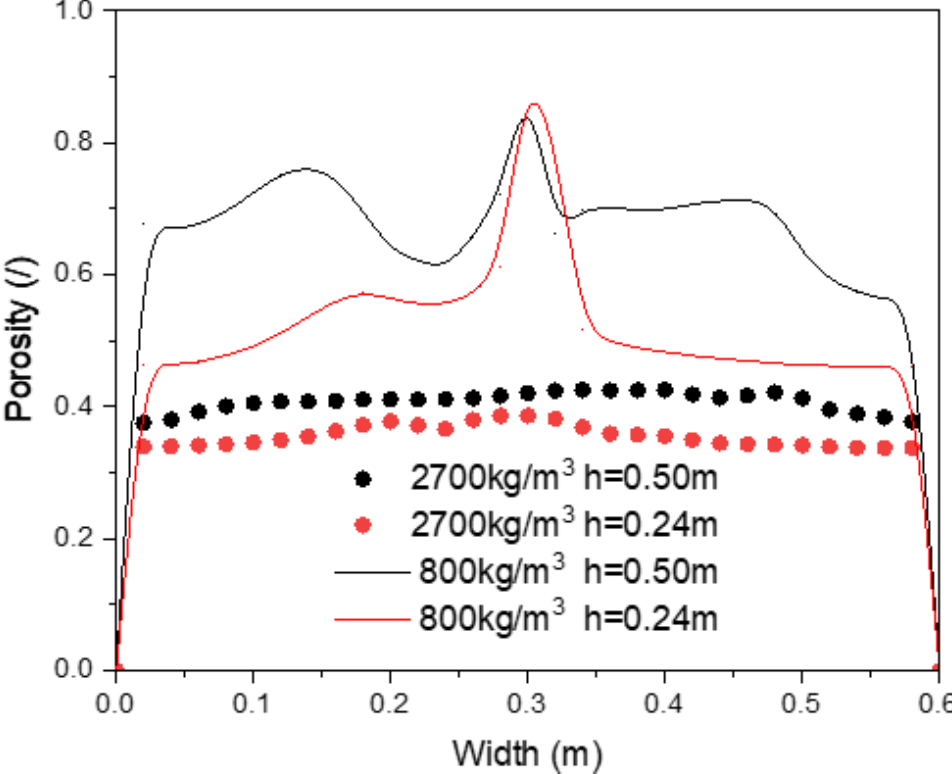
Figure 15. Comparisons of porosities particles with density of ρ p = 2700 kg/m 3 and ρ p = 800 kg/m 3 at the height of 0.24 m and 0.5 m. Figure 16 denotes the comparisons of the averaged granular temperature of particles with density of ρ p = 2700 kg/m 3 and ρ p = 800 kg/m 3 at the height of 0.24 m and 0.5 m. Those ultralight particles are far greater than heavy particles counterparts, implying that the granular temperatures depend on flow patterns and oscillations of particles. Gas will pass through the particles to top surface in accompanying with much more particles; however, particles will backflow as porosity increases as a result of the intensification of particle collisions. Larger size bubbles caused by ultralight particles are favorable for inducing the violent particle falling and circulation rate surrounding the interior bubble, accounting for the larger porosity and smaller drag force. However, only smaller bubbles and breakups at local regions, rather than in the global bed, are produced by heavy particles, resulting in the weak particle collisions. Figure 17 shows the distributions of granular temperature of particles with a density of ρ p = 2700 kg/m 3 and ρ p = 800 kg/m 3 . Larger values mainly gather the surrounding regions of bubbles, and maximum values of ultralight particles are probably 4.0 times greater than those of heavy particles. Larger size bubbles with longer residence times makes more contributions to an increase in granular